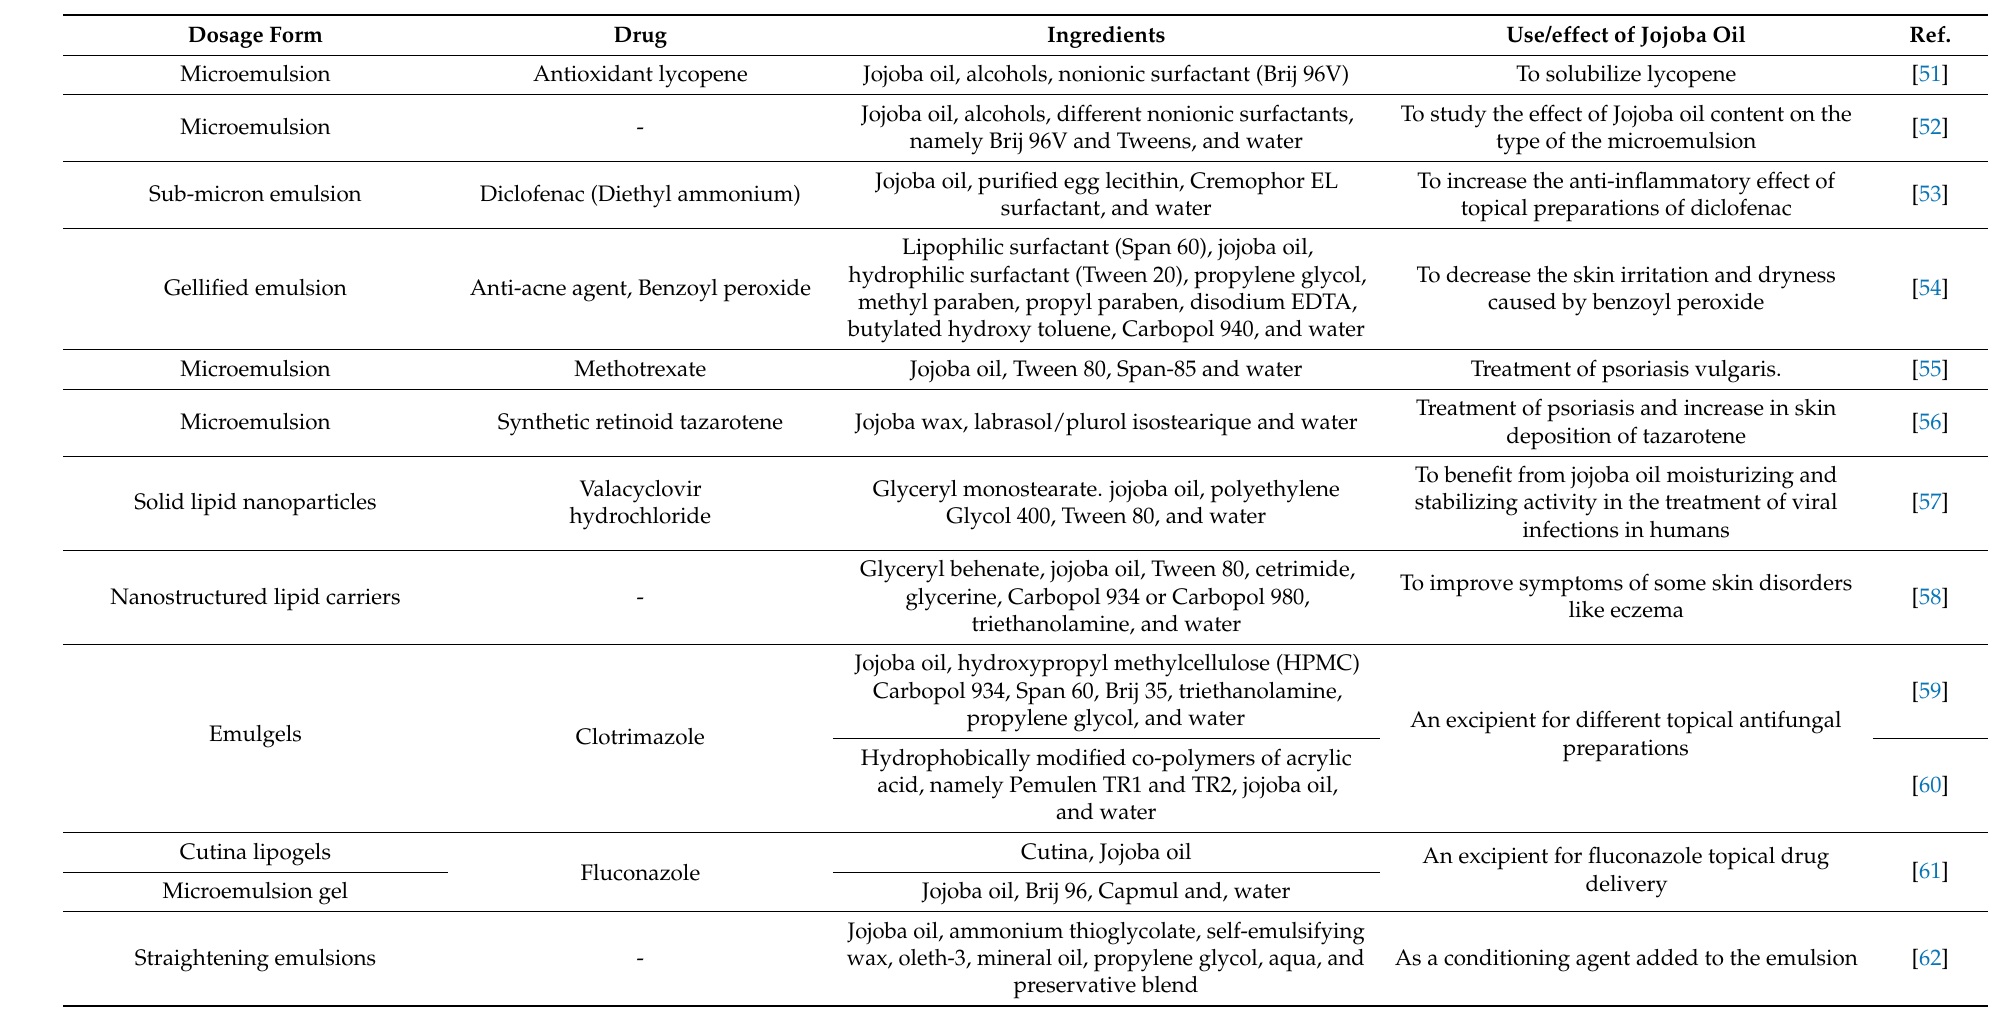
Table 7. A summary of pharmaceutical dosage forms containing jojoba